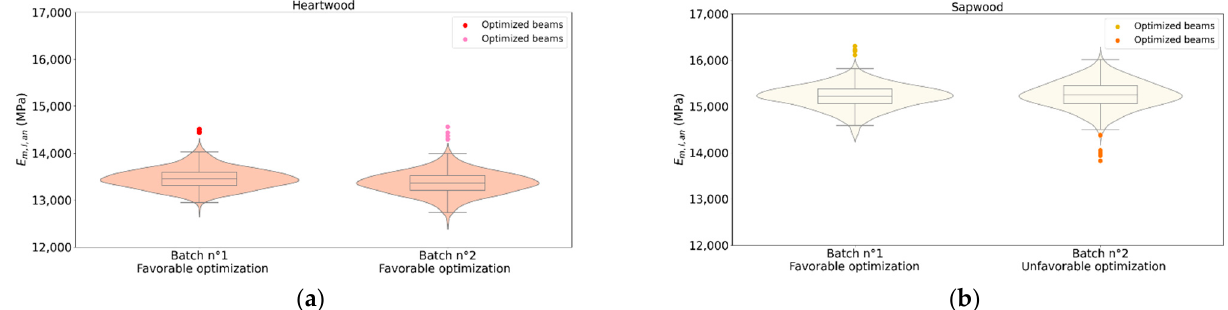
Figure 9. Local elastic modulus in bending results according to cases: ( a ) heartwood batches, ( b ) sapwood batches.